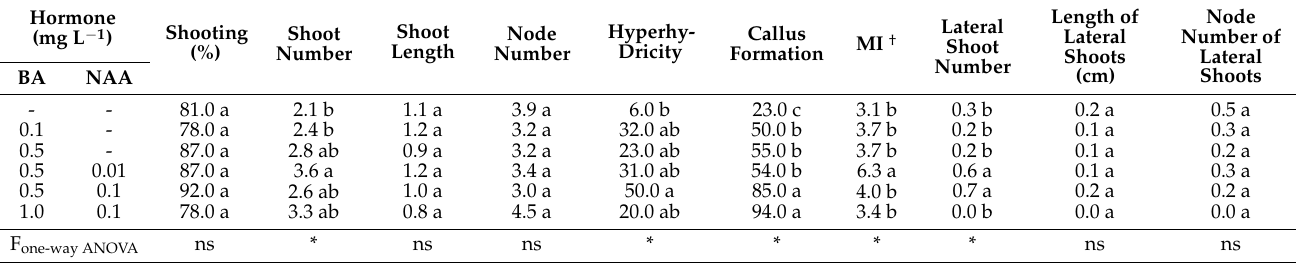
Table 3. Effect of various concentrations of BA and α -naphthaleneacetic acetic acid (NAA) on MS media on shoot proliferation of Sideritis raeseri subsp. attica during the first subculture.